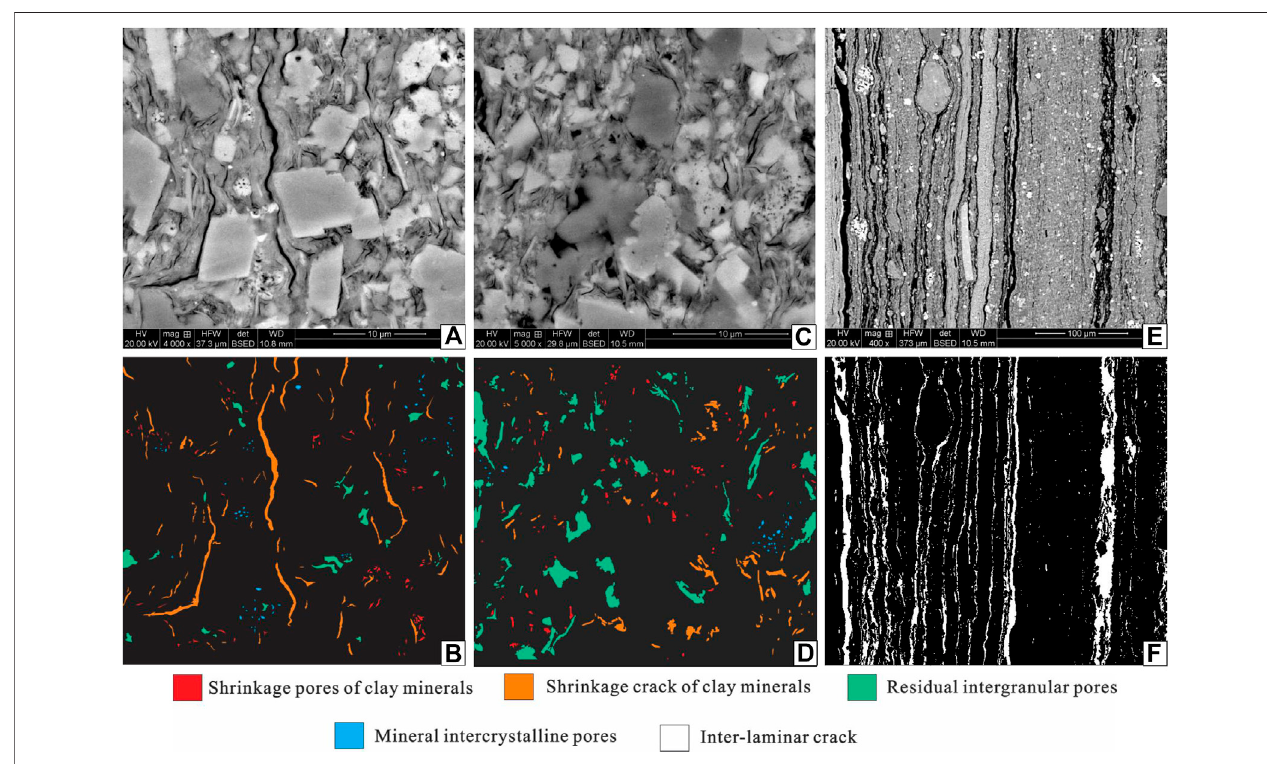
FIGURE7| SEMimagesafterargonionpolishingandimagesafterImageJprocessing. (A) ArgonionpolishingSEMimageoforganic-bearinglumpylimeclayrock, showing reservoir space including micro-cracks, clay mineral shrinkage pores, clay mineral intergranular pores, etc., 4,000x, GX27 Well, 2,314.95 m; (B) Image (A) processed with Image J; (C) Argon ion polishing SEM image of organic-bearing lumpy clay micritic limestone, showing reservoir space including interparticle pores, mineral intergranular pores, etc., 5,000x, GX27 Well, 2,315.29 m; (D) Image (C) processed with Image J; (E) Argon ion polishing SEM image of organic-rich laminoid lime clay rock, with extensively developed bedding cracks, 400x, GX27 Well, 2,313.75 m; (F) Image (E) processed with Image